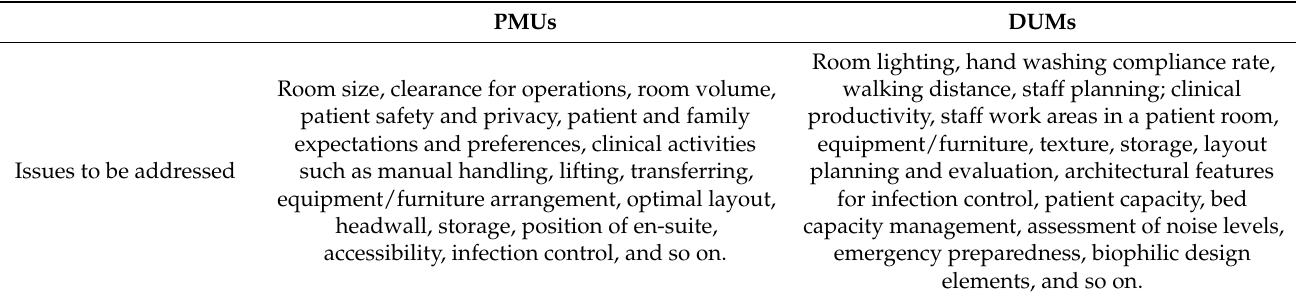
Table 3. Key issues to be addressed by using PMUs and